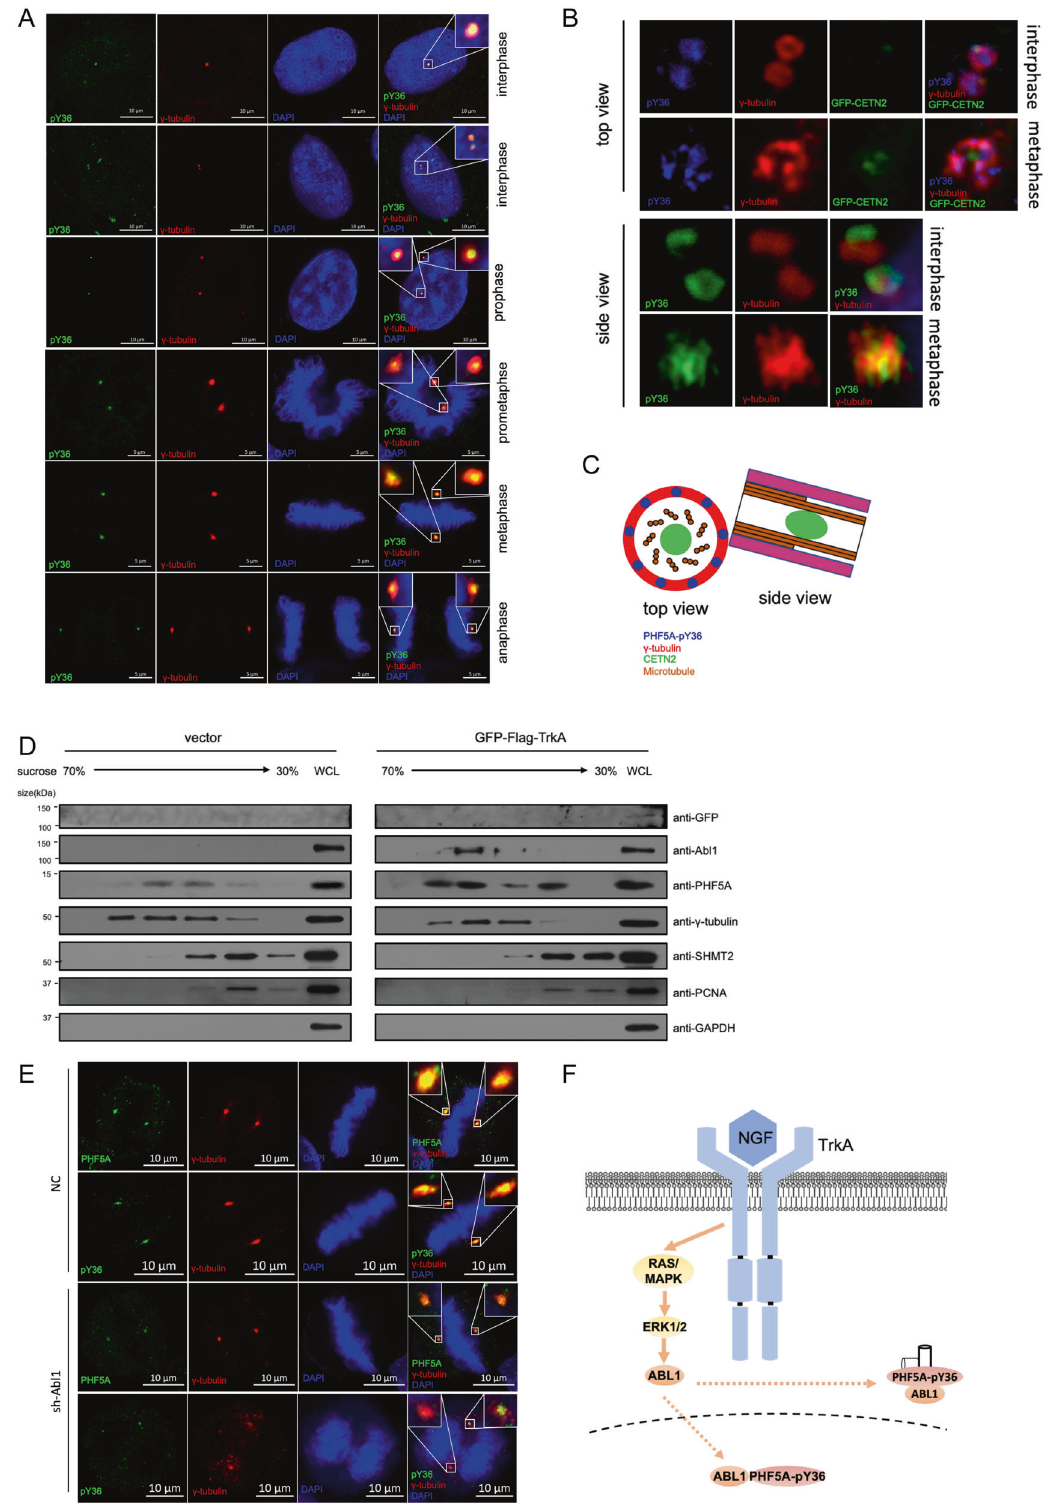
Fig. 3 ABL1 translocates to centrosome to phosphorylate PHF5A. A HeLa cells were co-stained with anti-pY36 and anti- γ -tubulin antibodies. Insets show the enlarged centrosomal region. B Super-resolution images of PHF5A-pY36 and γ -tubulin with or without stable overexpression of GFP-CETN2. C Model for centrosomal localization of PHF5A-pY36. D After enriching centrosomal fractions by centrifugation, endogenous PHF5A and ABL1 levels were measured in fractions of HEK293T whole-cell lysates (WCL) with or without the expression of GFP-Flag-TrkA. E HeLa cells were infected with sh-Abl1 lentivirus or control lentivirus and stained with PHF5A or PHF5A-pY36. F Model for ABL1 translocation and phosphorylation of PHF5A in the centrosome.